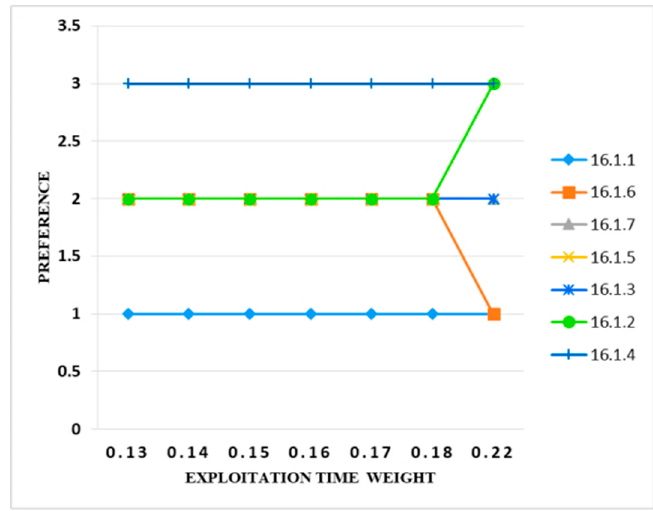
Figure 14. Sensitivity analysis of preference and exploitation time weight.